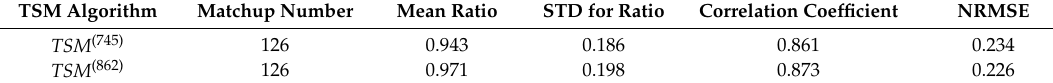
Table 1. Statistics for VIIRS-derived and in situ-measured TSM comparison in Lake Taihu.